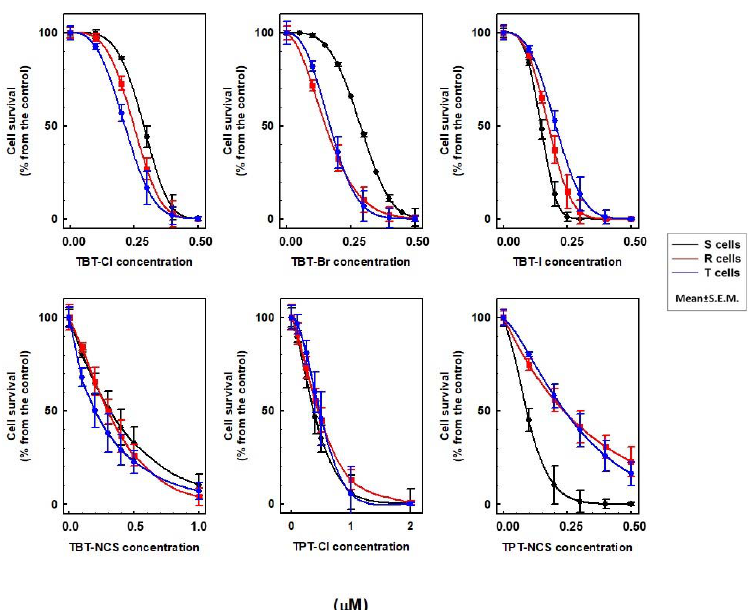
Figure 1. The cell death effects of triorganotin derivatives on S, R and T cells. The cells’ prior measurements were 48 h cultivated in cultivation medium in the absence or presence of the respective triorganotin derivatives at different concentrations. The data were fitted by nonlinear regression according to Equation (1) using SigmaPlot 8.0 software (Systat Software, Inc., San Jose, CA, USA). The data represent the means ± S.E.M. from six independent measurements corresponding IC 50 values are summarized in Table 2.